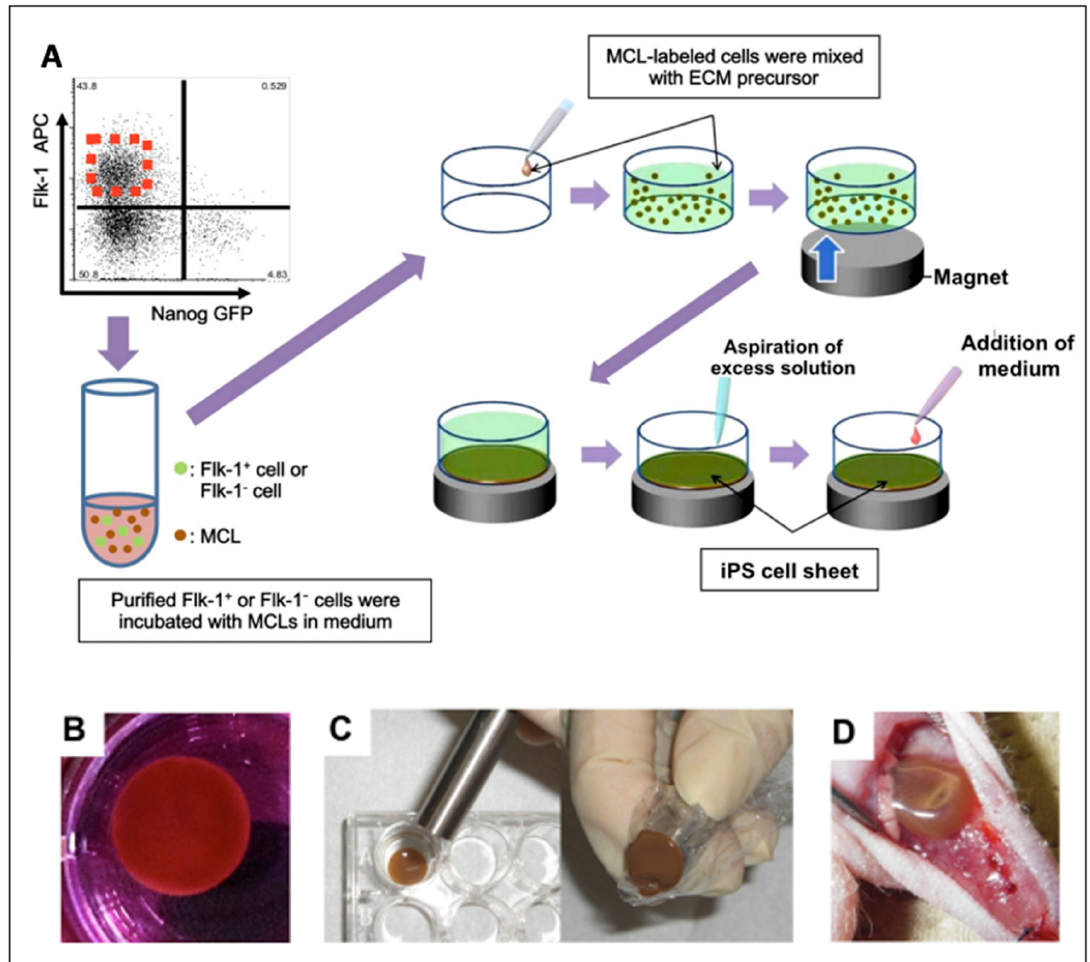
Figure 10. ( A ) Scheme for preparing iPS cell sheets. After fluorescence-activated cell sorting, iPS cells with (Flk-1 + ) and without (Flk-1 - ) Flk-1 receptor were incubated with MCLs for 2 h. Labeled cells were then mixed with ECM in ultra-low attachment plates followed by placement on a cylindrical magnet to obtain cell sheets. ( B ) The iPS cell sheet floated on the surface of culture media with the help of a magnet. ( C ) The sheet was transferred to the magnet covered with a polyvinylidene difluoride (PVDF) membrane. ( D ) Using the same magnet, the sheet was placed on the adductor muscles of mice. Reprinted with permission from Ref. [141]. Copyright 2013 Springer Nature.